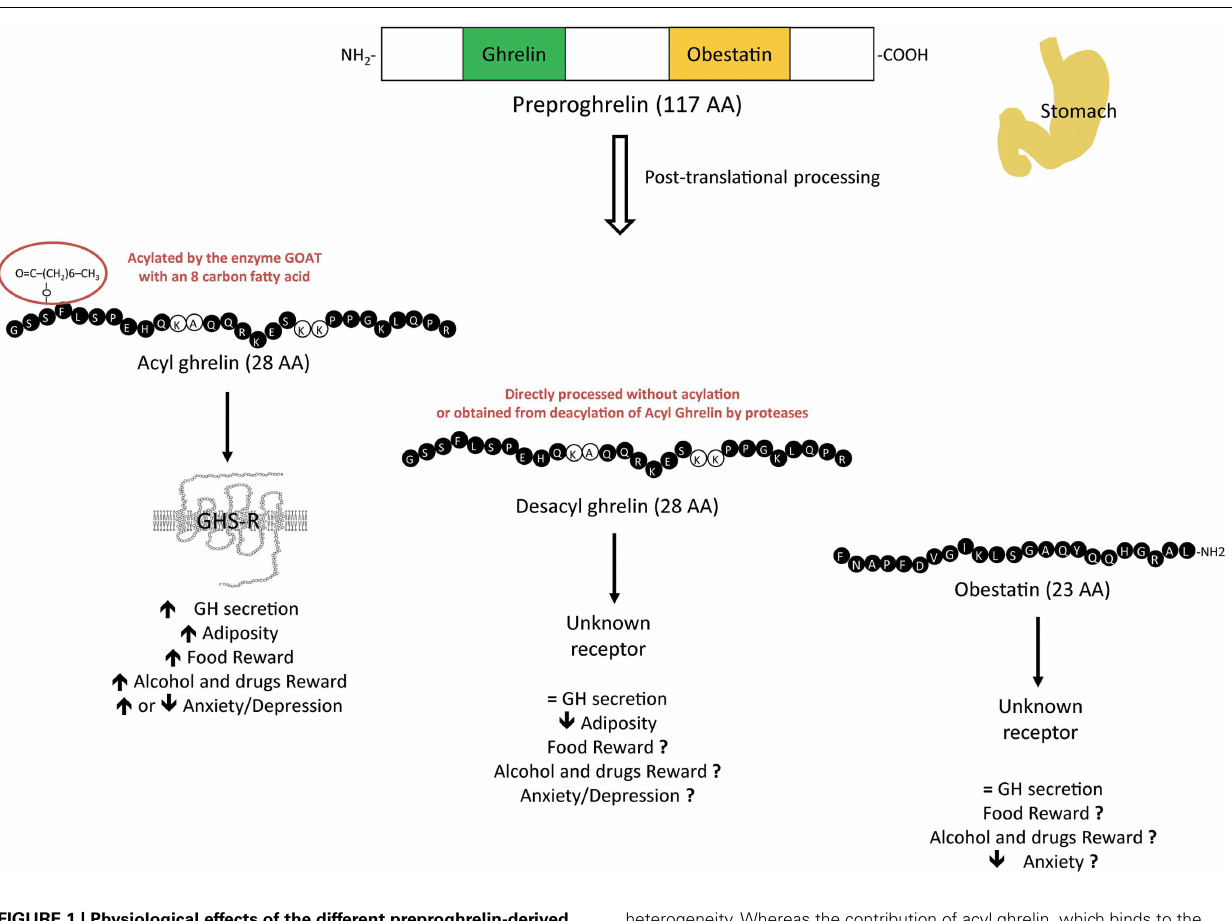
FIGURE 1 | Physiological effects of the different preproghrelin-derived peptides on GH secretion, adiposity, food reward, drugs reward, and anxiety/depression . Preproghrelin is a unique prohormone as it encodes several preproghrelin-derived peptides with structural and functional